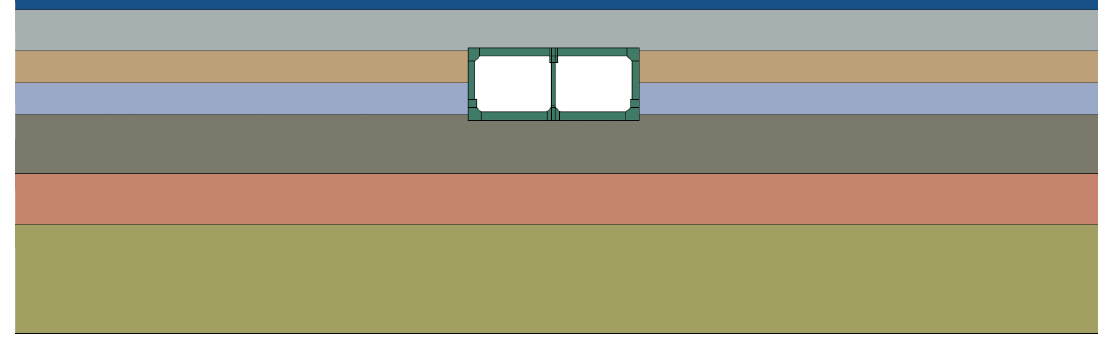
Figure 9. Location between subway station and soil.